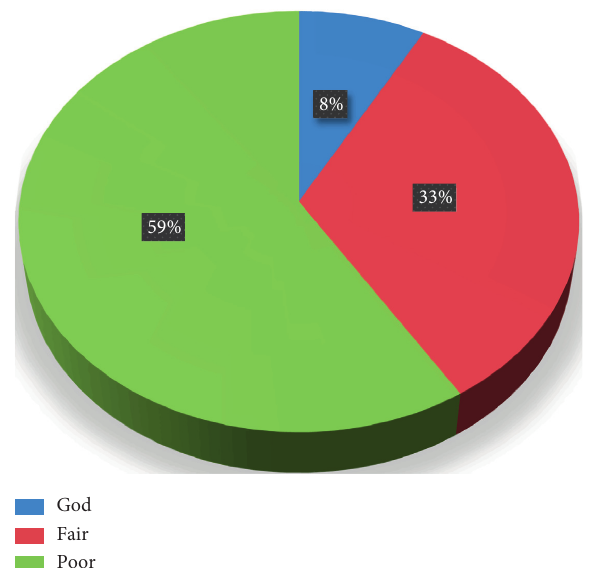
Figure 2: Category of nurses’ knowledge regarding physical re- straint ( n � 112).